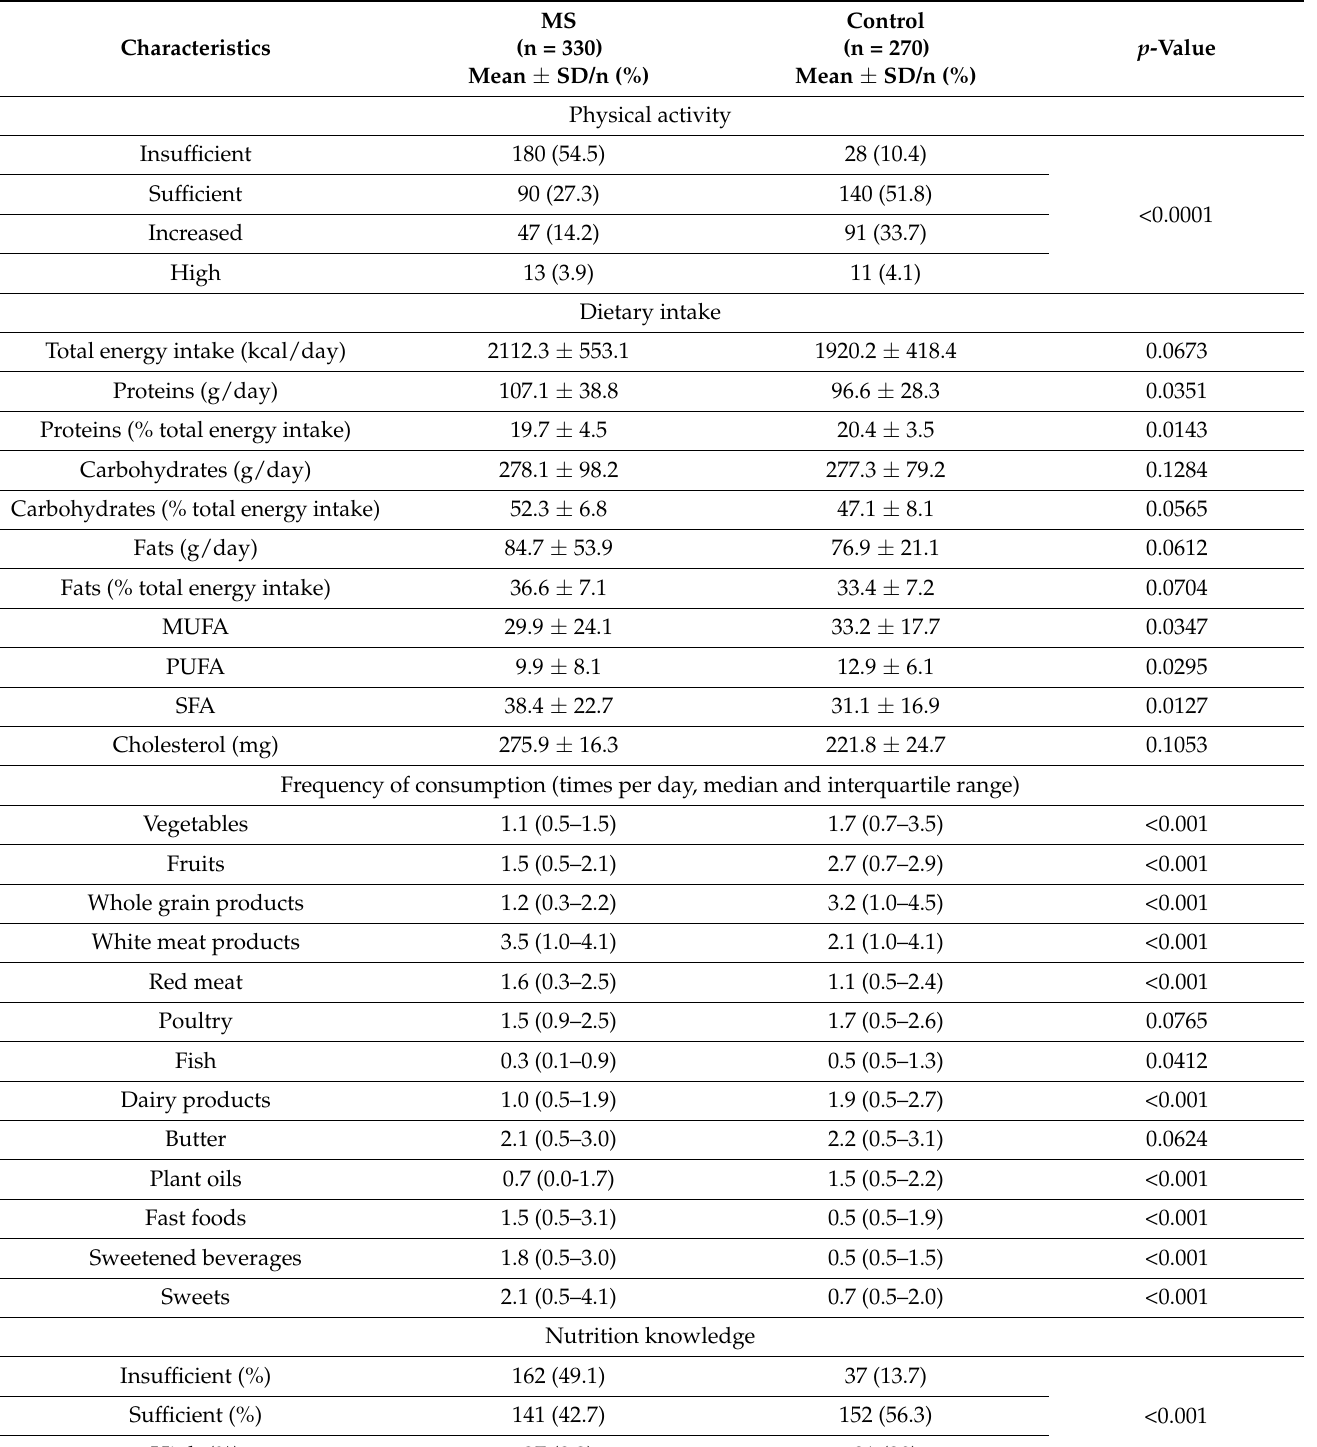
Table 2. Physical activity and dietary characteristics of study